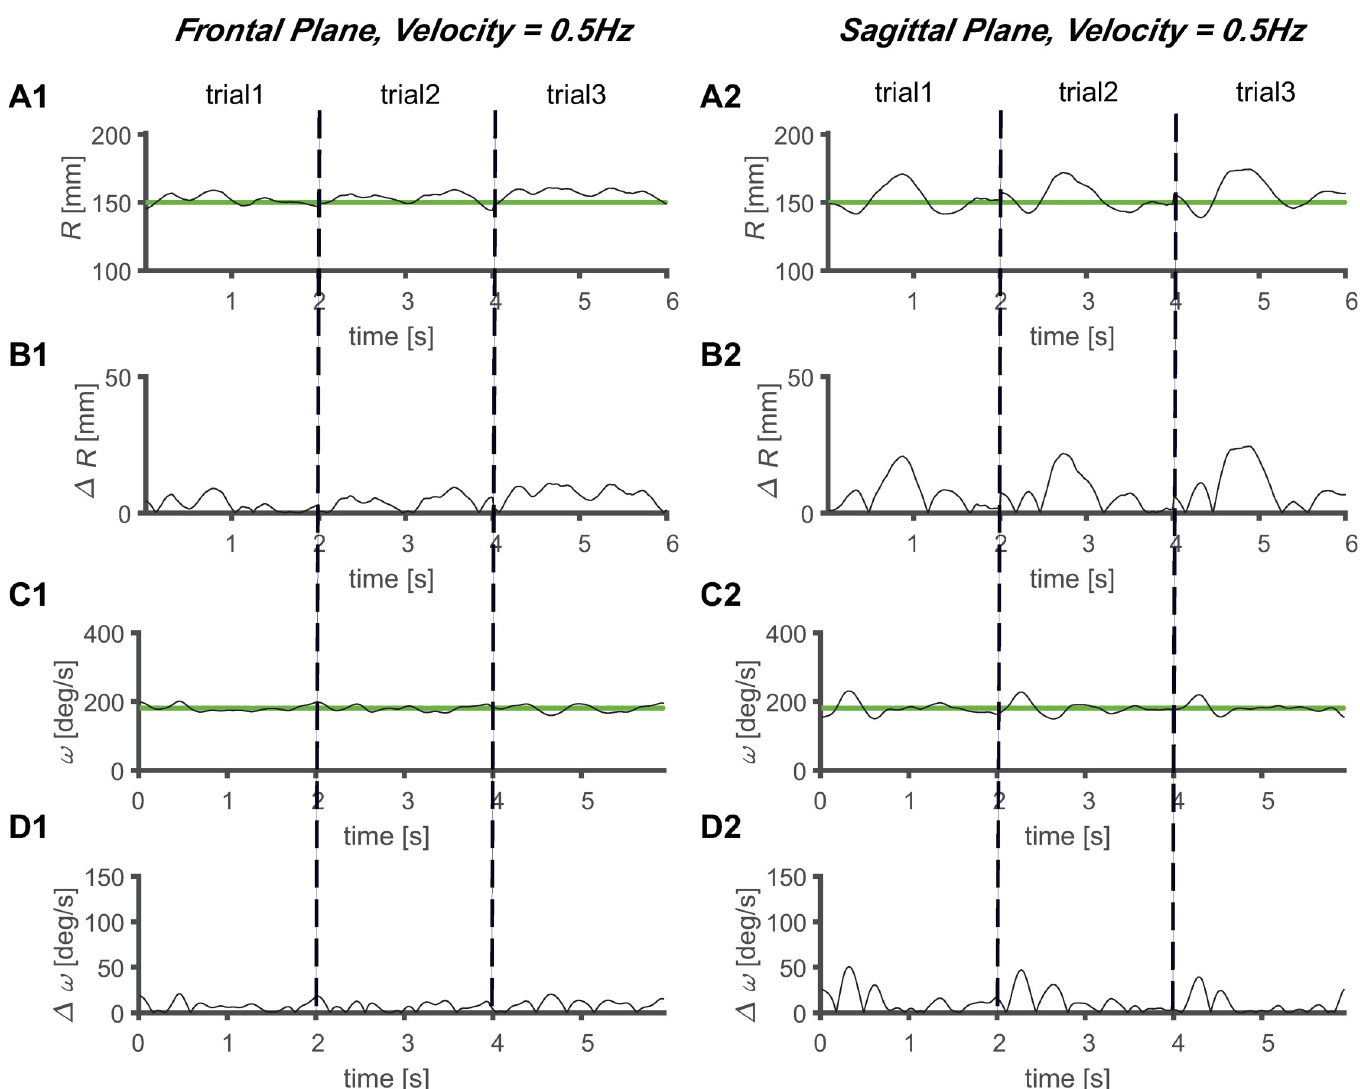
Fig 7. Average circular tracking movement at 0.5 Hz. R value for three trials on the (A1) frontal plane (A1) and (A2) sagittal plane. Absolute value of Δ R on the (B1) frontal plane (B1) and (B2) sagittal plane. ω value for three trials on the (C1) frontal plane (C1) and (C2) sagittal plane. Absolute value of Δ ω on the (D1) frontal plane (D1) and (D2) sagittal